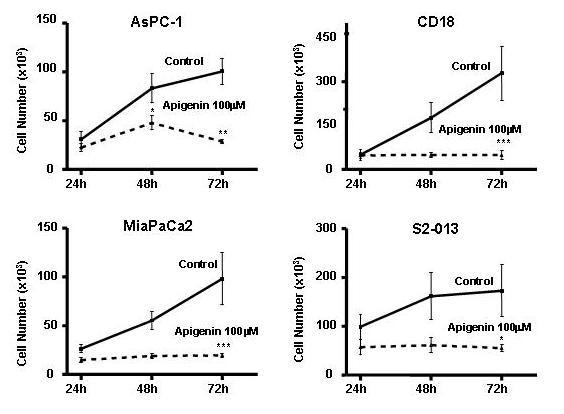
Time-course effects of apigenin on cell number of human pancreatic cells. Apigenin significantly inhibited the increase in cell number of each cell line over time: AsPC-1, [F (5,59) = 10.65, P < 0.0001], P < 0.05 at 48 h and P < 0.001 at 72 h; CD18, [F (5,38) = 5.641, P < 0.0006], P < 0.001 at 72 h; MIA PaCa2, [F (5,65) = 6.127, P < 0.0001], P < 0.001 at 72 h; S2-013, [F (5,60) = 2.589, P < 0.0347], P < 0.05 at 72 h. Data represent results from at least three separate experiments each performed in triplicate, expressed as cell number/well. *= P < 0.05; **= P < 0.01; ***= P < 0.001 compared with control.